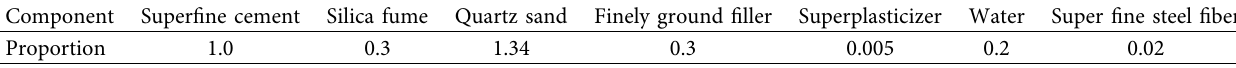
Table 1: Distribution ratio of each group of UHPC.